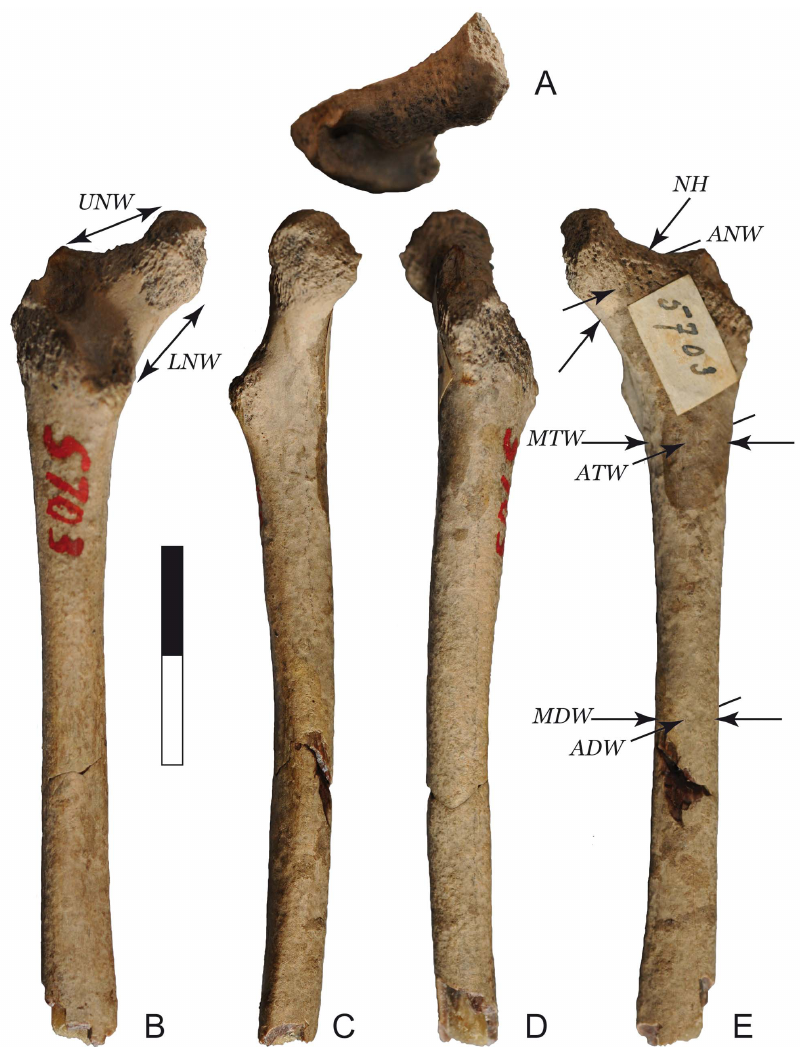
Figure 2. View of Trinil 5703 femur. A : Proximal view; B : Posterior view; C : Medial view; D : Lateral view; E : Anterior view.